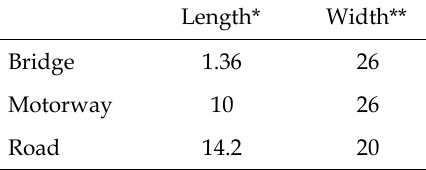
Infrastructure components length and